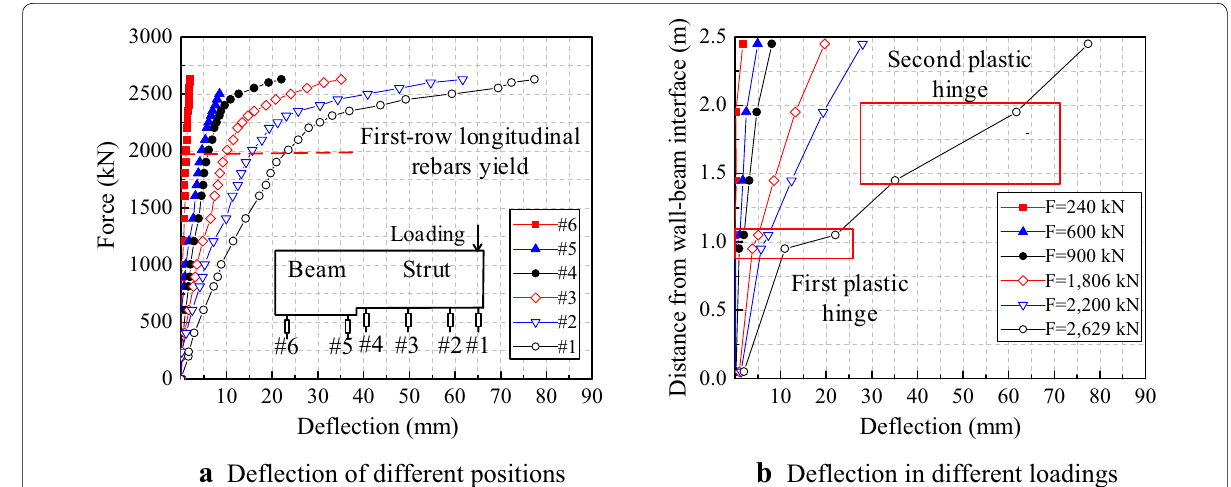
Fig. 8 Deflection curves.